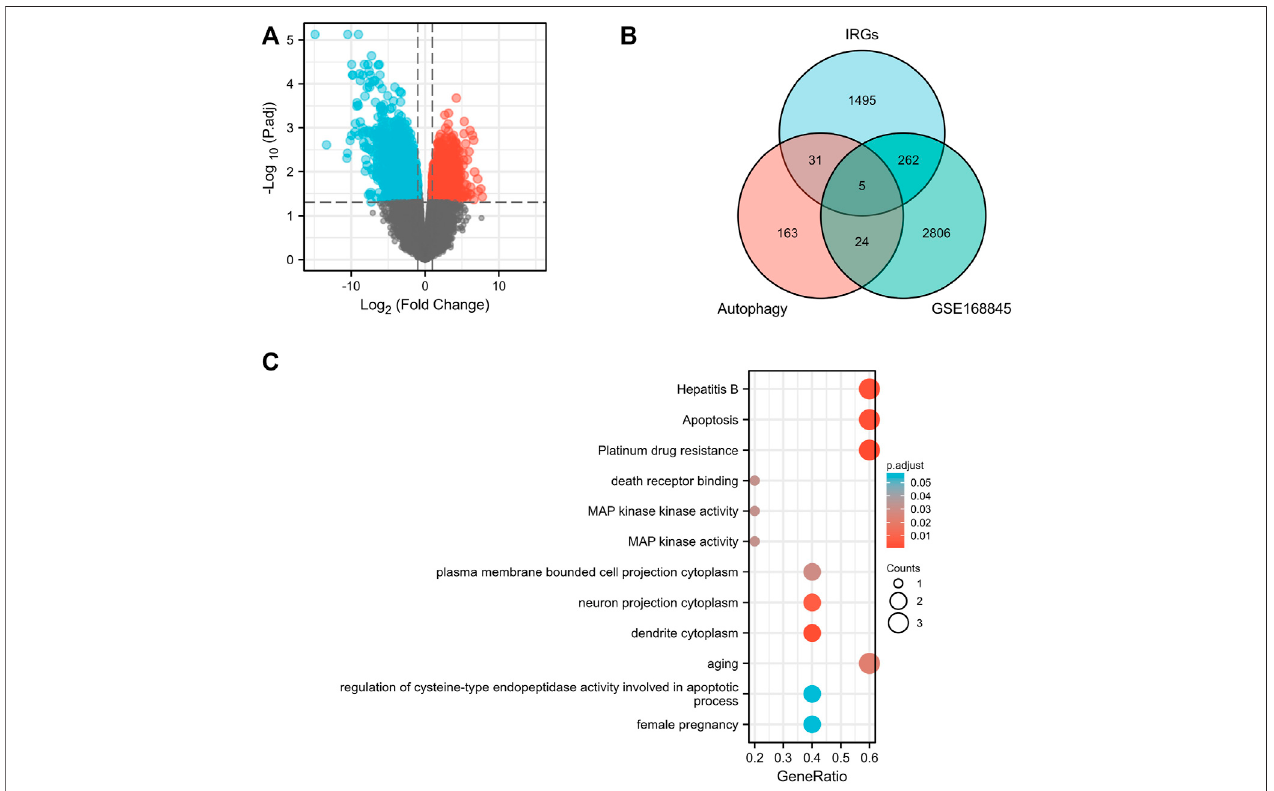
FIGURE 1 | Screening of differentially expressed genes. Volcano plots of differentially expressed genes (DEGs) between normal renal tissues and renal cancer in GSE168845 samples (A) . Adjusted p -value < 0.05 and log2-fold change (absolute) > 1.3; 635 DEGs were screened with 1,826 upregulated genes and 1,809 downregulated genes. Red represents upregulated genes, and blue indicates downregulated genes. A total of 1,793 human immune-related genes (IRGs) were downloaded from ImmPort database (https://www.immport.org./home), and a total of 223 human autophagy-related genes were downloaded from the Human Autophagy Database(HADb) (http://autophagy.lu/clustering/index.html). Venn diagram showing the fi ve immune-autophagy genes according to the three datasets (B) . Graph showing the Gene Ontology (GO) and Kyoto Encyclopedia of Genes and Genomes (KEGG) analysis of the fi ve immune-autophagy genes (C) . The fi ve immune- autophagy genes were CANX, MAPK1, BIRC5, NAMPT, and